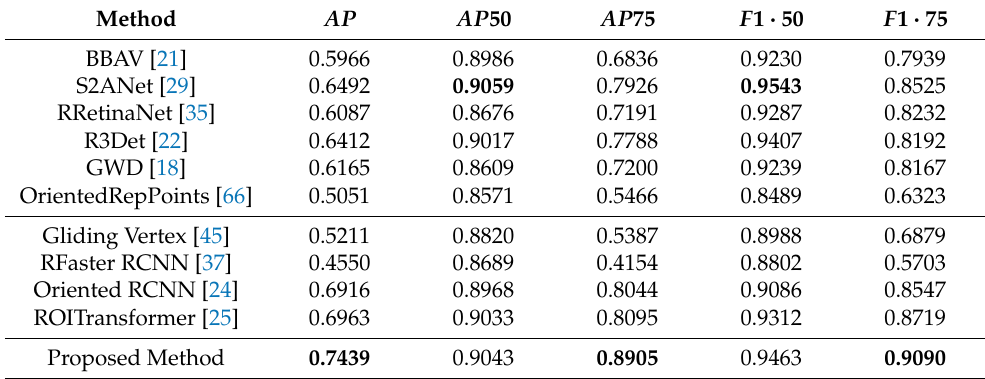
Table 9. Quantitative Results on